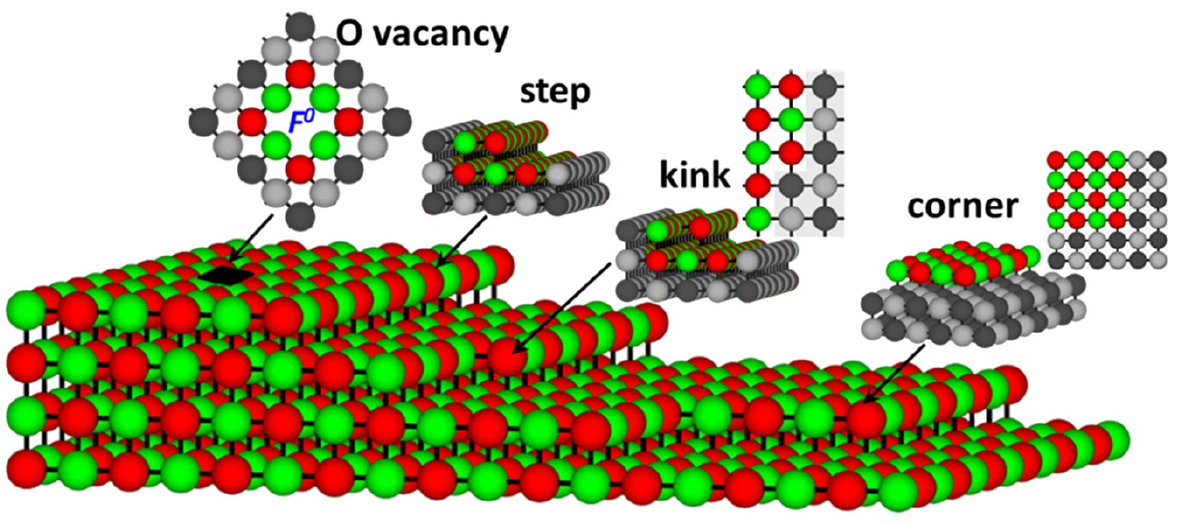
Figure 2. Schematics of the several coordination defects at (001) MgO surface: O vacancy, step, kink, and corner. Mg—in green, O—in red. Atoms that do not belong to the top surface layer are shown in black (oxygen) and gray (magnesium).